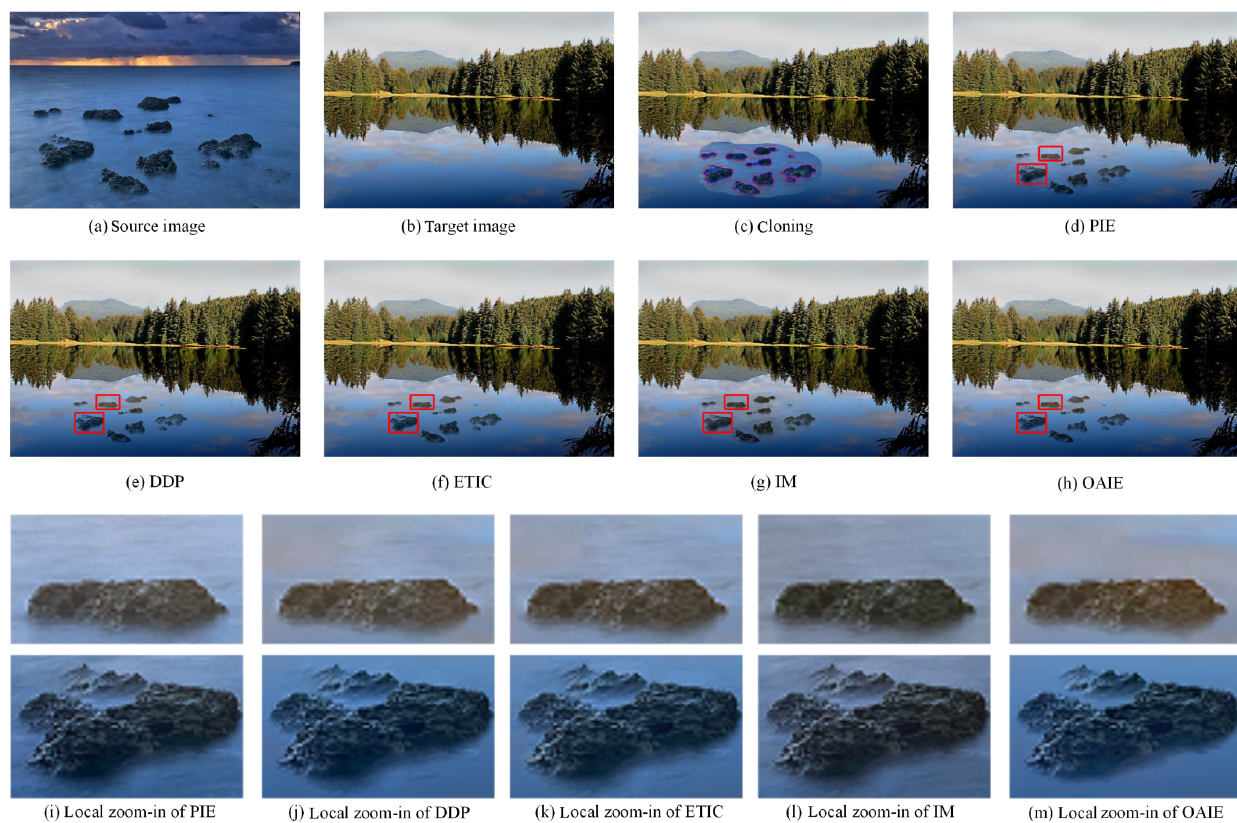
Fig. 2 Seamless cloning for combining a region containing multiple objects with a target image. Results generated by the four other methods have artifacts in the background while OAIE provides a more natural result since it considers a unified constraint on both object appearance and background texture